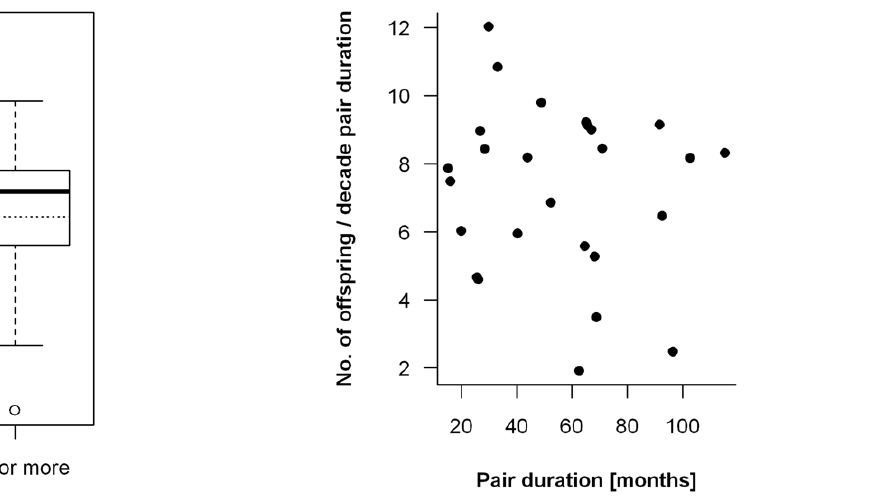
Figure 2. Correlation between the number of offspring per decade of pair duration and the total length a pair lasted.